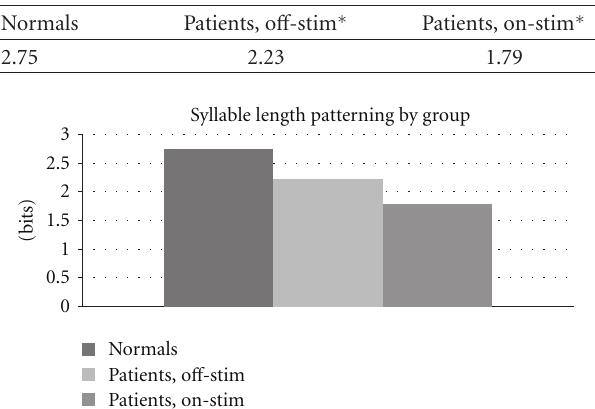
Figure 2: Syllable length patterning, across groups. Lower values indicate random variations in length. Normal values significantly di ff erent from patient values ( P ≤ . 002). Patients on-stim signif- icantly di ff erent from patients o ff -stim ( P < . 005).